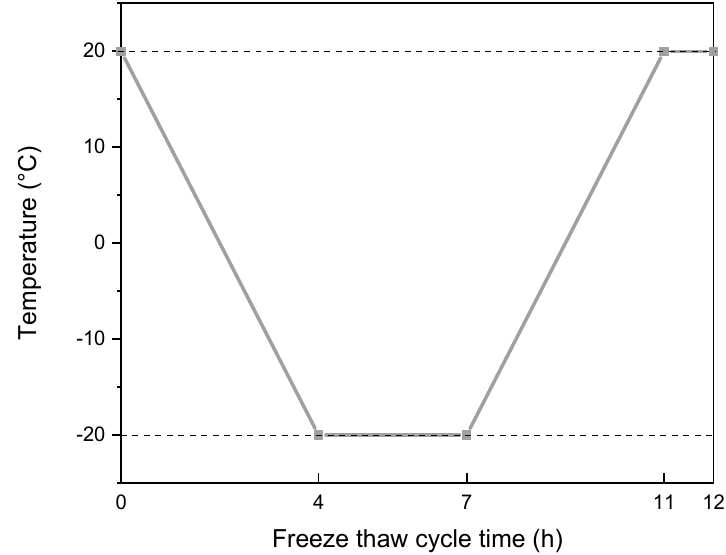
Figure 3. One typical cycle in a freeze–thaw cycle program.